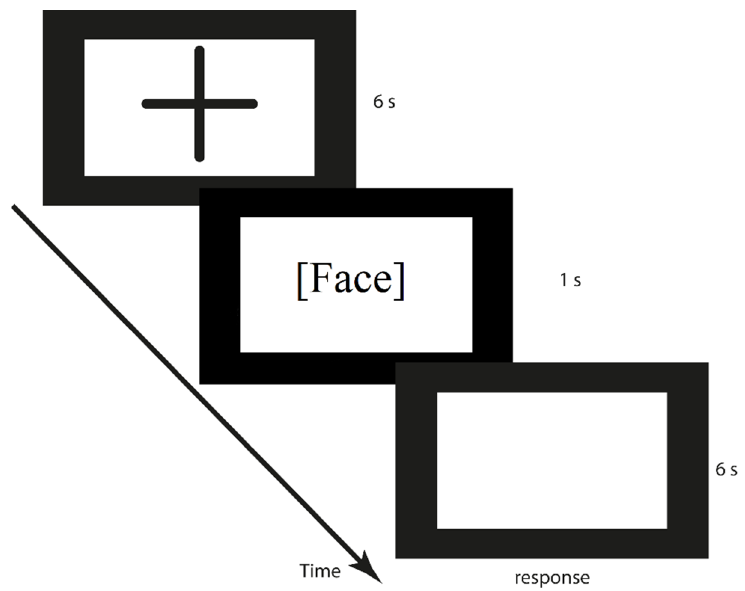
Figure 1. Illustration of the experimental procedure.